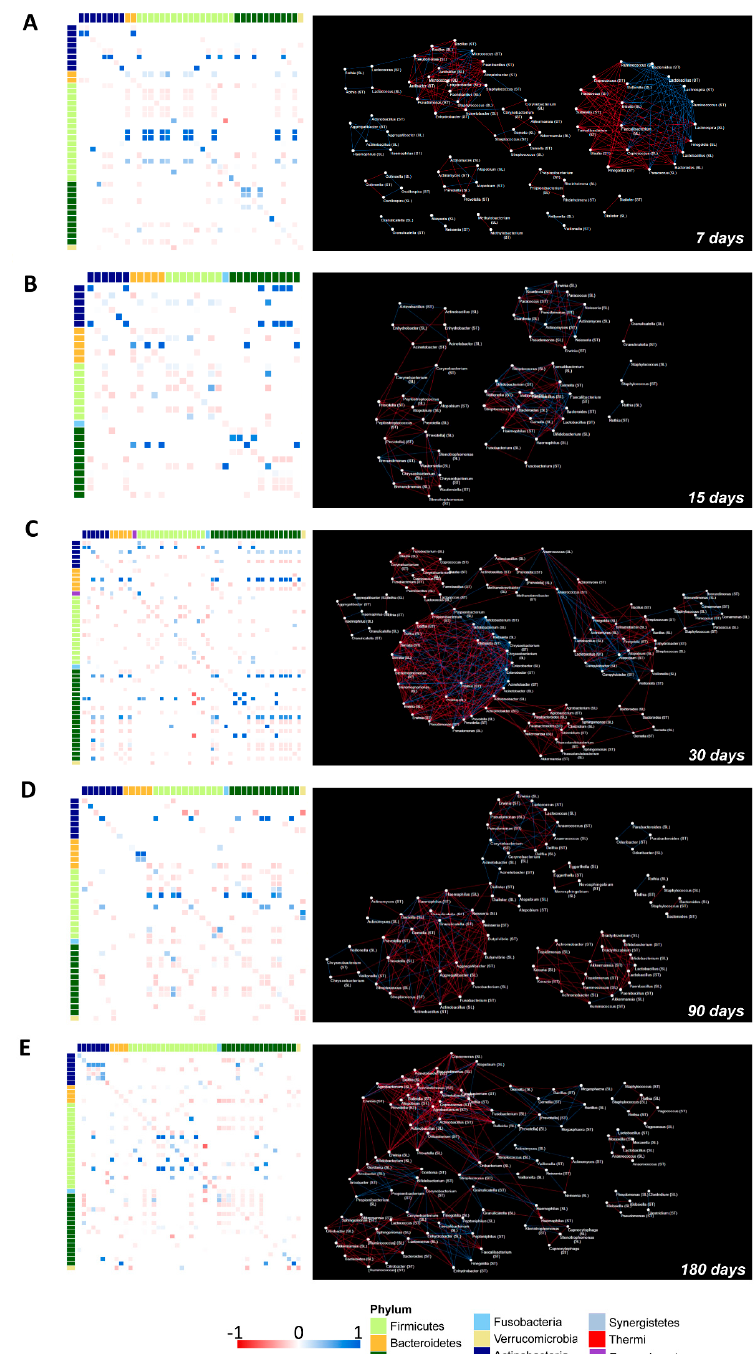
Figure 8. Correlation heatmaps and the OTUs co-occurrence networks of the saliva versus the stool microbiota from 7 to 180 days following birth. On the left side, Pearson’s correlation heatmaps between saliva versus stool OTUs. Panels ( A – E ) show the correlation (colored squares) heatmaps between the saliva versus the stool OTUs at days 7, 15, 30, 90, and 180. Pearson’s correlations with p FDR < 0.05 are presented. The color scale represents the correlation level of each variable: red, negative correlation values; blue, positive correlation values. The OTUs are colored according to the phylum taxonomy. OTUs co-occurrence networks are represented on the right side of the figure, calculated on heatmap correlations. The blue line indicates a positive correlation and the red line indicates a negative